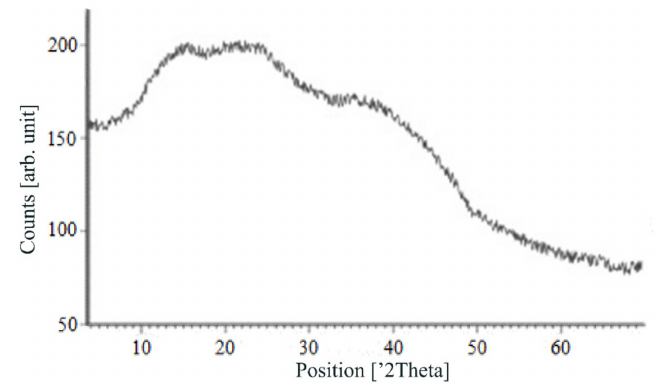
Figure 7. X-ray di ff raction patterns of pristine alginate-based aerogel.